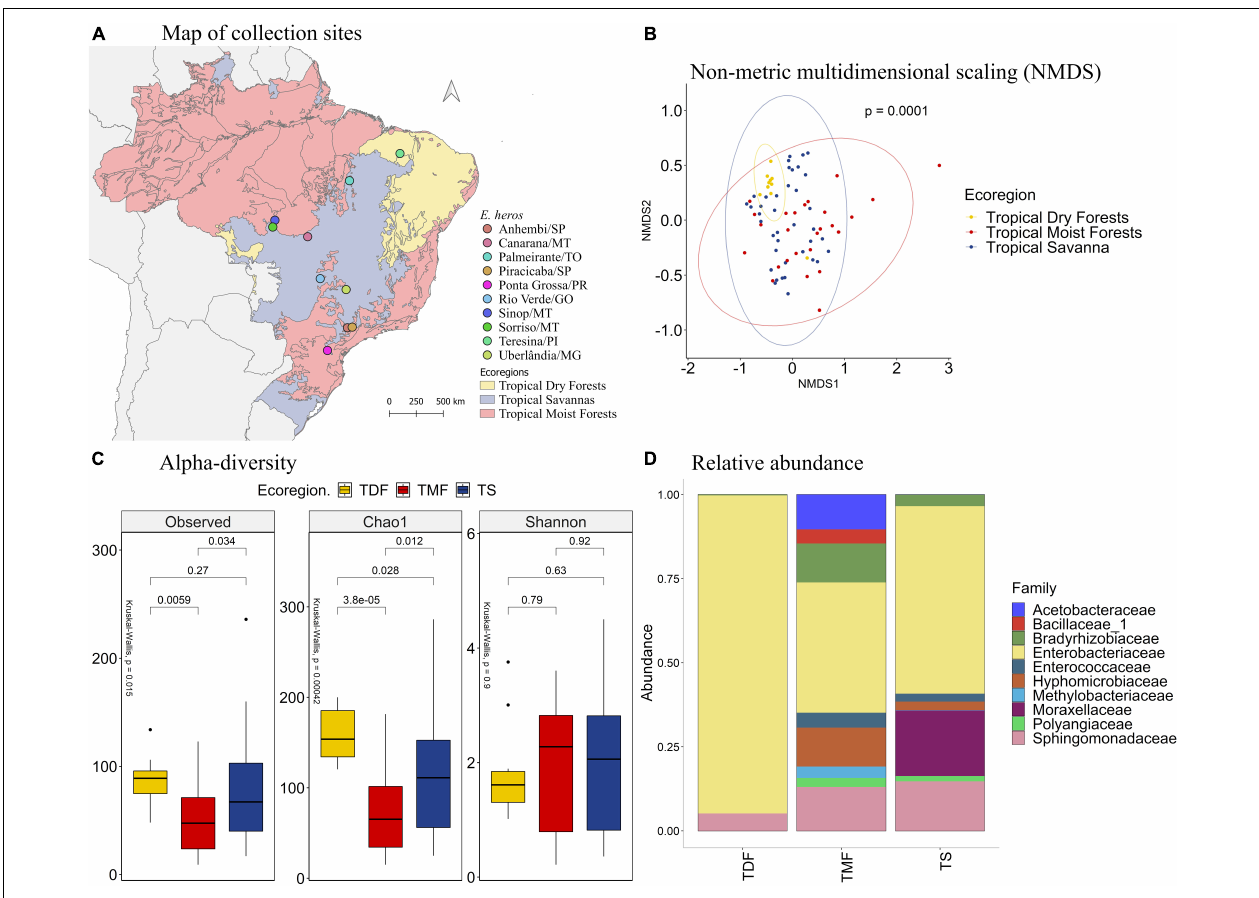
FIGURE 1 | (A) Map of collection sites of E. heros , classified by ecoregion in Brazil. (B) NMDS of Bray-Curtis similarity matrix among 75 samples from the intestinal microbiome of E. heros , for the different ecoregions from Brazil. The ellipses are showing clustering between ecoregions. Permutational multivariate analysis of variance (PERMANOVA) is indicated in the upper right. (C) Alpha diversity levels based on Observed OTU, Chao1 index and Shannon index for the different ecoregions. The non-parametric test (Kruskal–Wallis) is indicated in the upper left of each graph. Pairwise comparison (Wilcoxon) is indicated between Ecoregions. (D) Analysis of the ten most abundant bacteria families in the intestinal microbiome of E. heros collected in Brazil, classified by